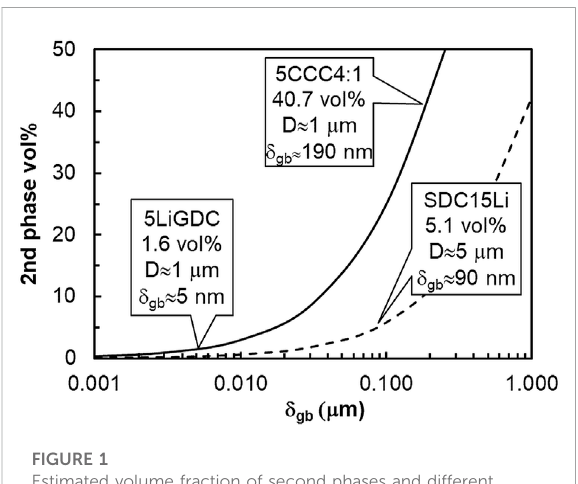
FIGURE 2 Total conductivity ( σ ) versus the reciprocal of absolute temperature (1/T) of Ca-doped ceria electrolytes with and without salts, and possible secondary phases (Cerisier and Roux, 1978; Janz and Tomkins, 1983; Guth et al., 1987; Yamashita et al.,